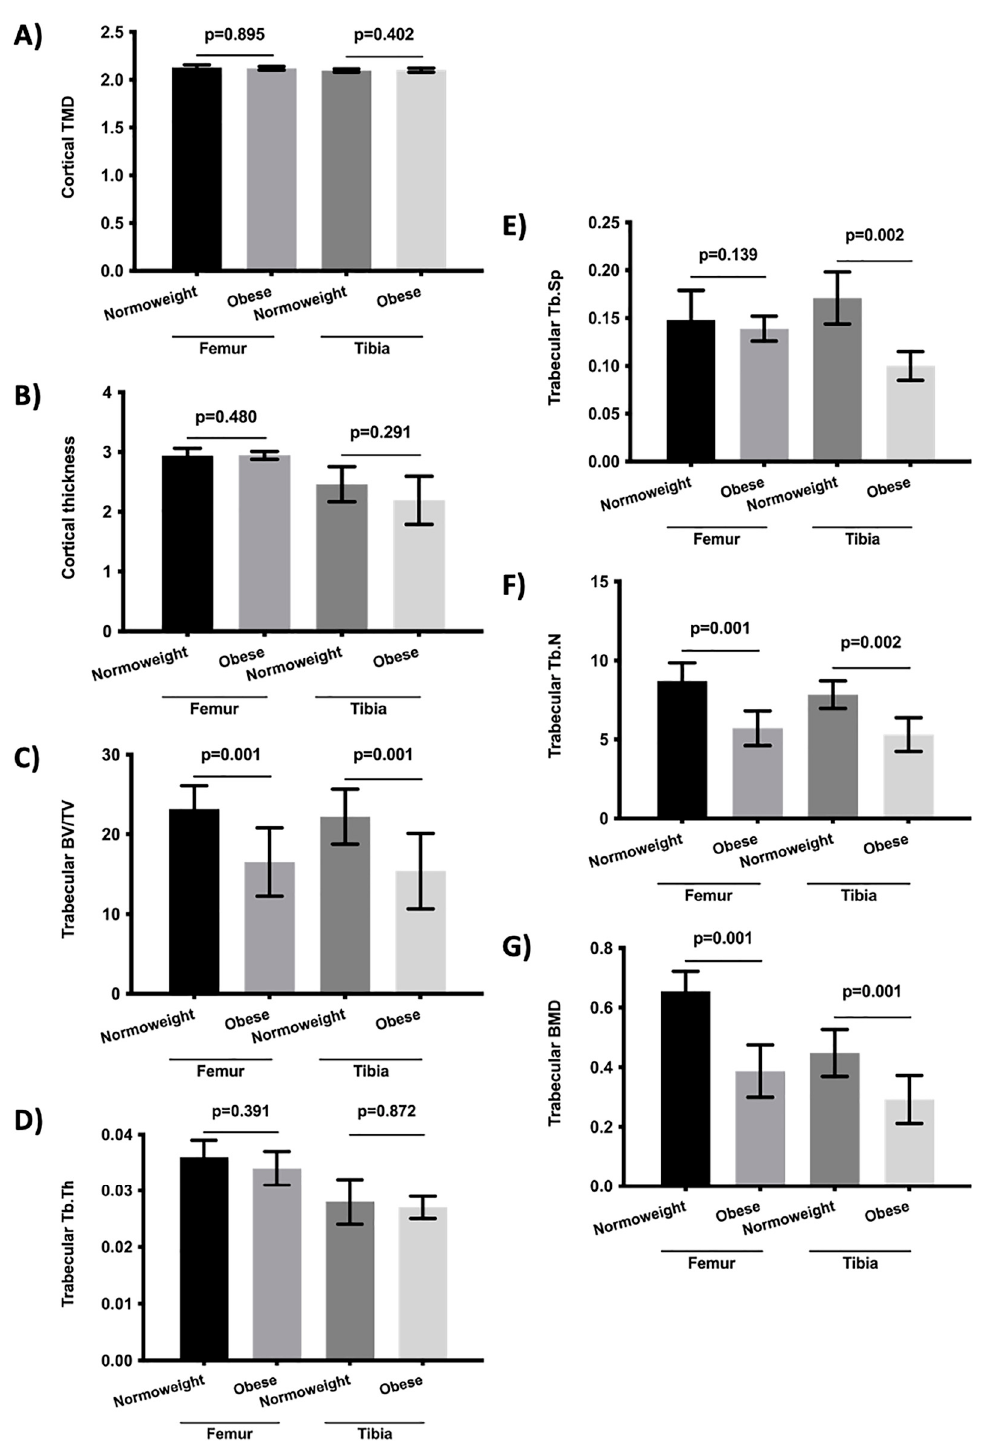
Figure 3. Comparison of bone morphometry parameters between normoweight and obese rats subject to chronic hypoxia. ( A ) Cortical TMD, ( B ) cortical thickness, ( C ) trabecular BV/TV, ( D ) Tb.Th, ( E ) Tb.Sp, ( F ) Tb.N, and ( G ) trabecular BMD. Variables are presented as mean (standard deviation). TMD: tissue mineral density, BV/TV: percent bone volume; Tb.Th: trabecular thickness; Tb.Sp: trabecular separation; Tb.N: trabecular number; and BMD: bone mineral density.